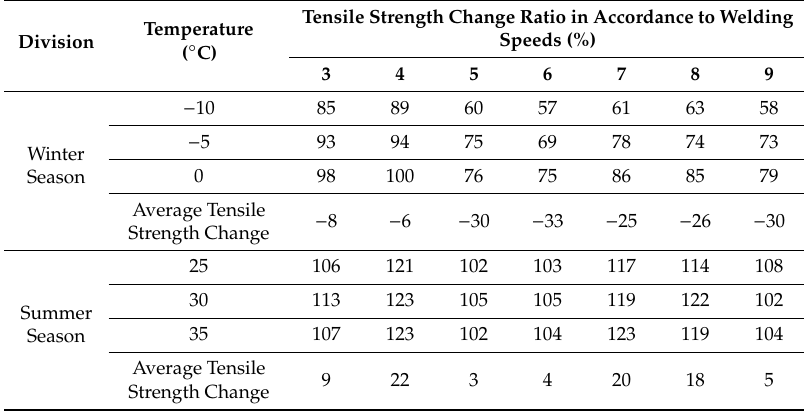
Table 11. Tensile strength change compared to the normal temperature condition (20 ◦